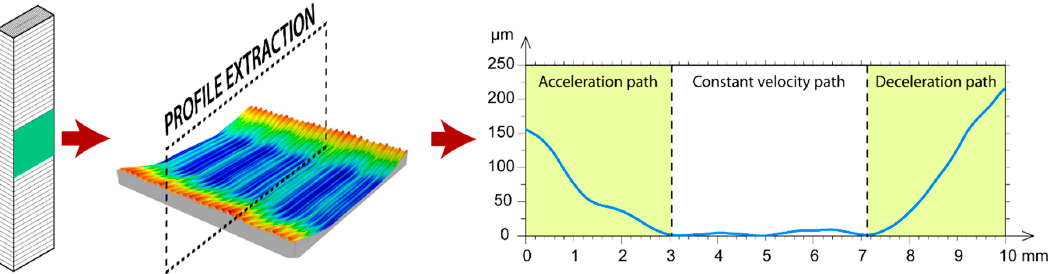
Figure 8. Detail of profile extraction in an upright orientation.